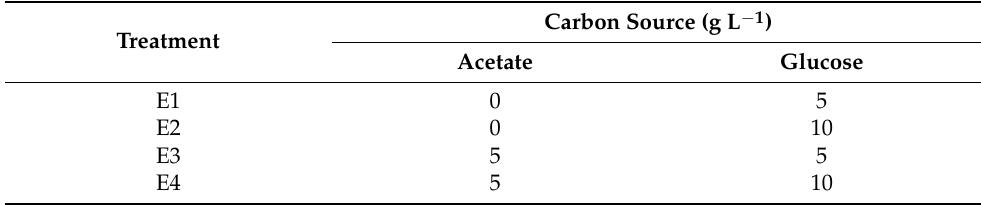
Table 1. Experimental design for the quantification of respiratory activity on the heterotrophic growth of C. sorokiniana